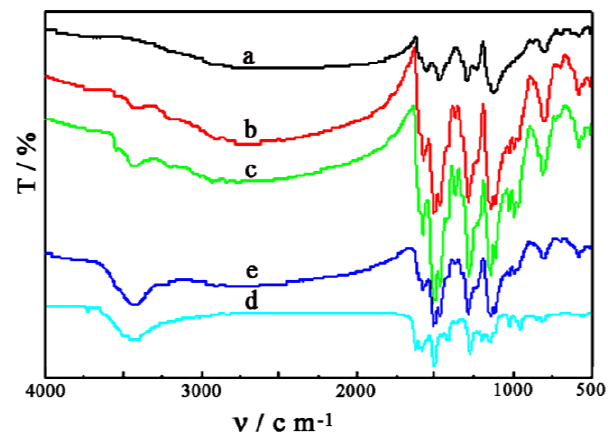
Figure 4. IR spectra of samples with different reaction times at room temperature: ( a ) 4 h; ( b ) 8 h; ( c ) 12 h; ( d ) 16 h and ( e ) 20